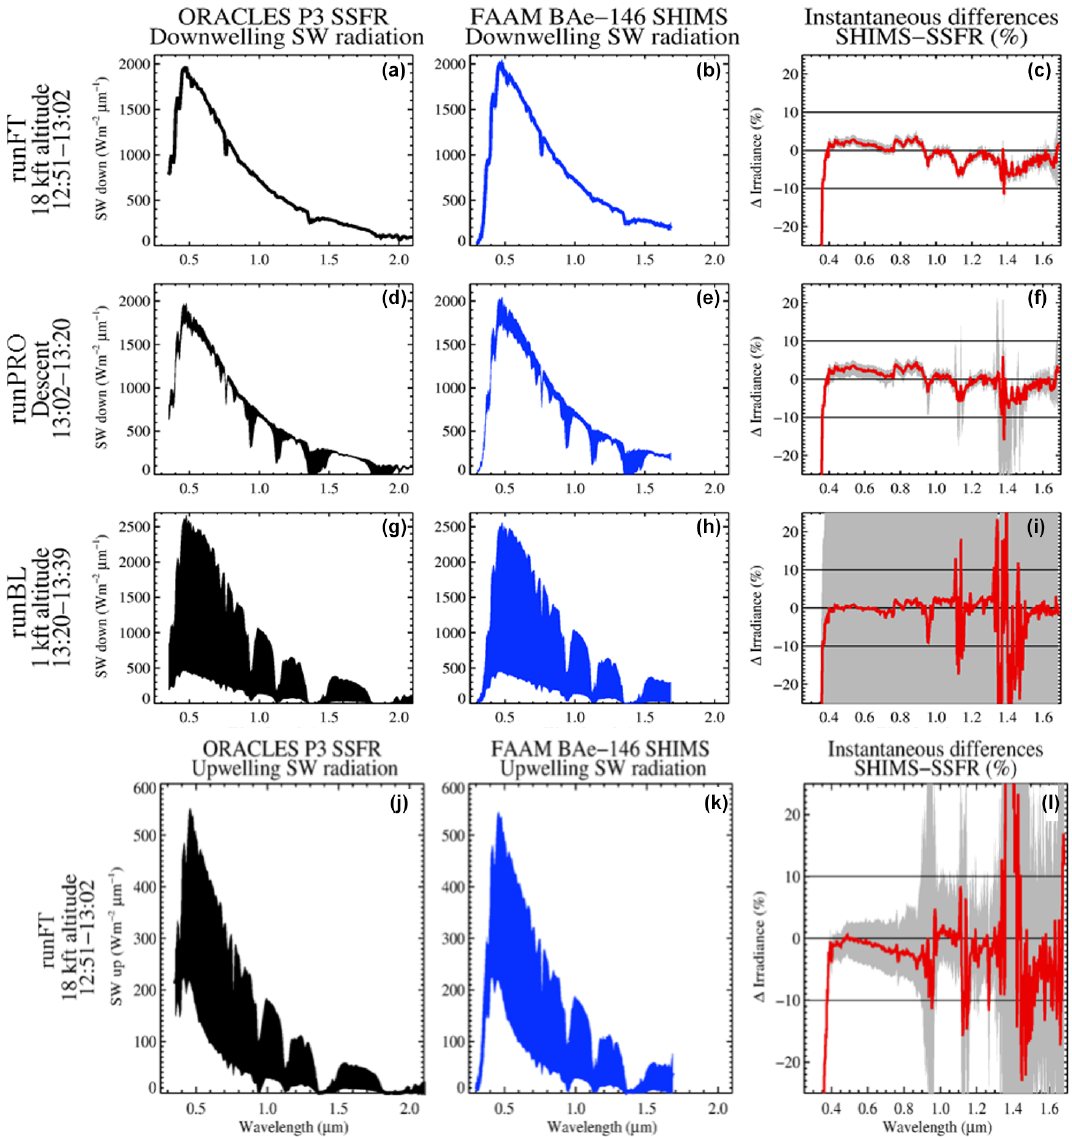
Figure 10. Intercomparison of downwelling shortwave spectral irradiance from (a, d, g, j) ORACLES NASA P3 and (b, e, h, k) CLARIFY FAAM BAe-146 and (c, f, i, l) percentage differences for three wing-tip-to-wing-tip manoeuvres: (a–c) runFT, (d–f) runPRO and (g–i) runBL. Intercomparison of upwelling shortwave spectral irradiance for runFT (as a–c ). Filled black and blue contours in (a) , (d) , (g) , (j) , (b) , (e) , (h) and (k) show the observed spectral irradiance ranges. Filled grey contours in (c) , (f) , (i) and (l) show the range of percentage differences in paired measurements, overlaid with the average percentage difference (red